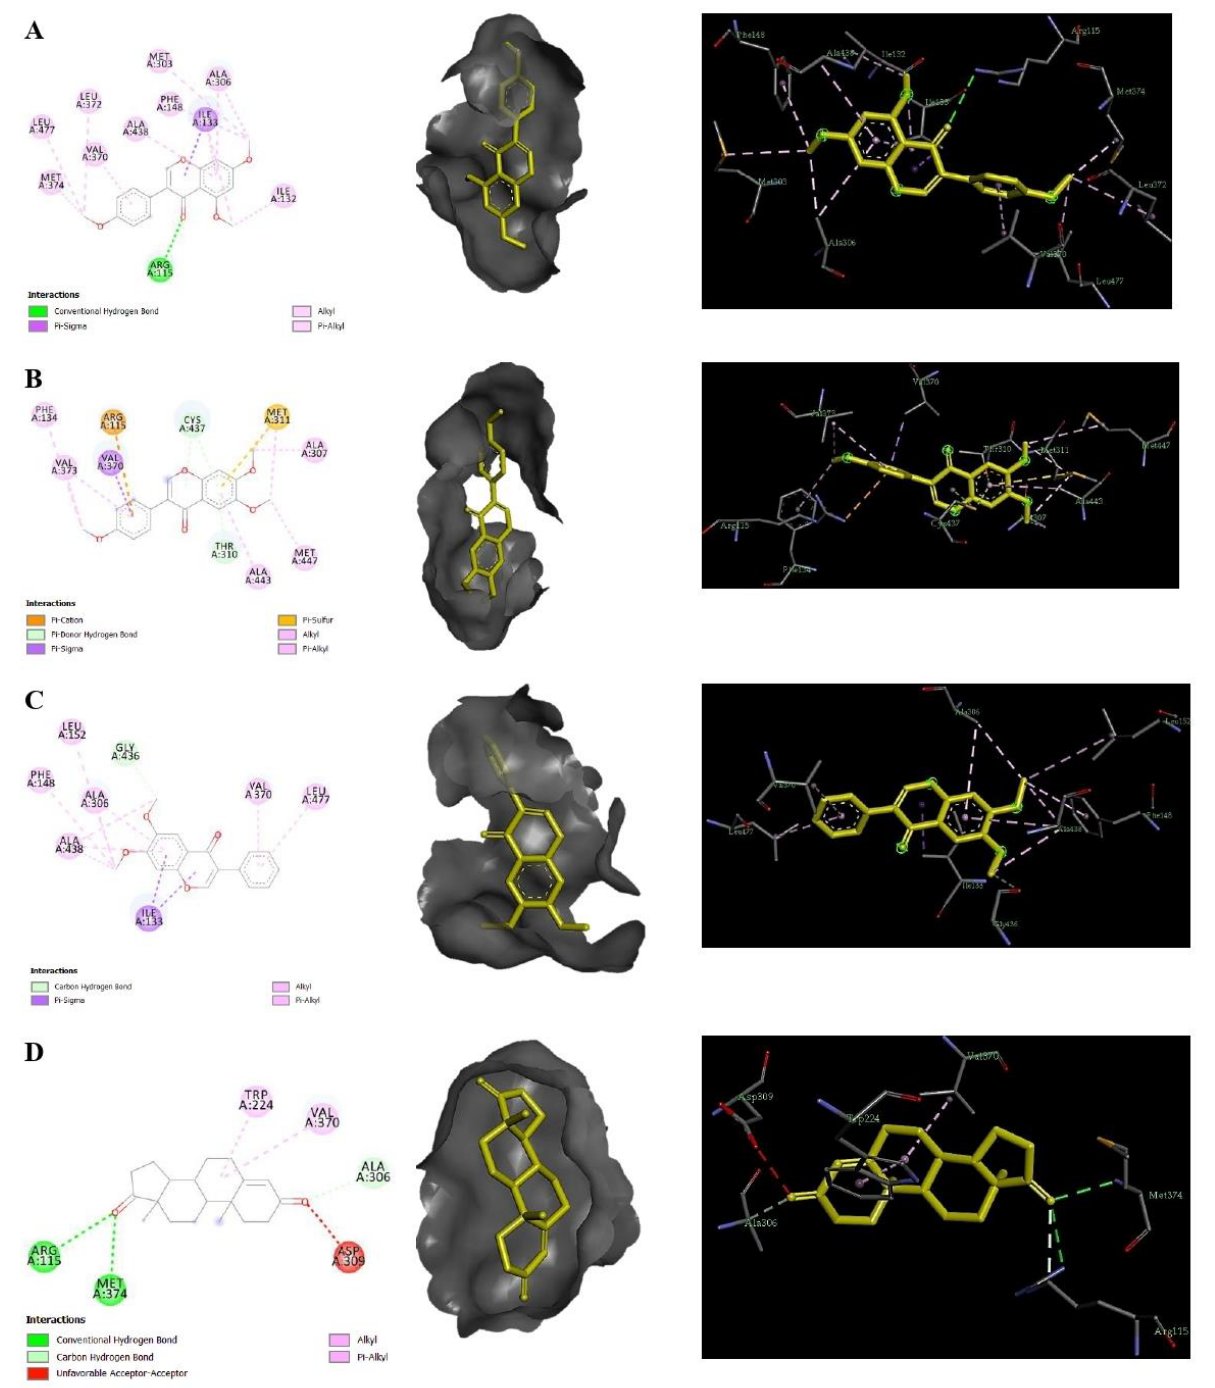
Figure 6. Interaction of 52 ( A ), 50 ( B ), 54 ( C ) and androstenedione ( D ) with the binding cleft of 3EQM, shown in 3D and 2D representations.